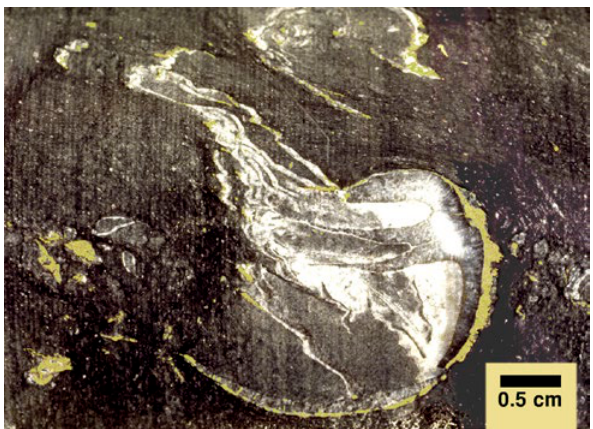
Figure 86. A distorted carbonate fossil is from pyritic black shales at Mt. Bulga N.S.W. The plastic or semi-fluid nature of the distor- tion indicates the way in which the original carbonate had been hydrolysed to hydroxy carbonate at the time of distortion. This is confirmed by its partial replacement by sulphide which requires hydrolysis (or gelation) before the sulphide particles can diffuse into the material to substitute for the hydroxycarbonate they are displac-